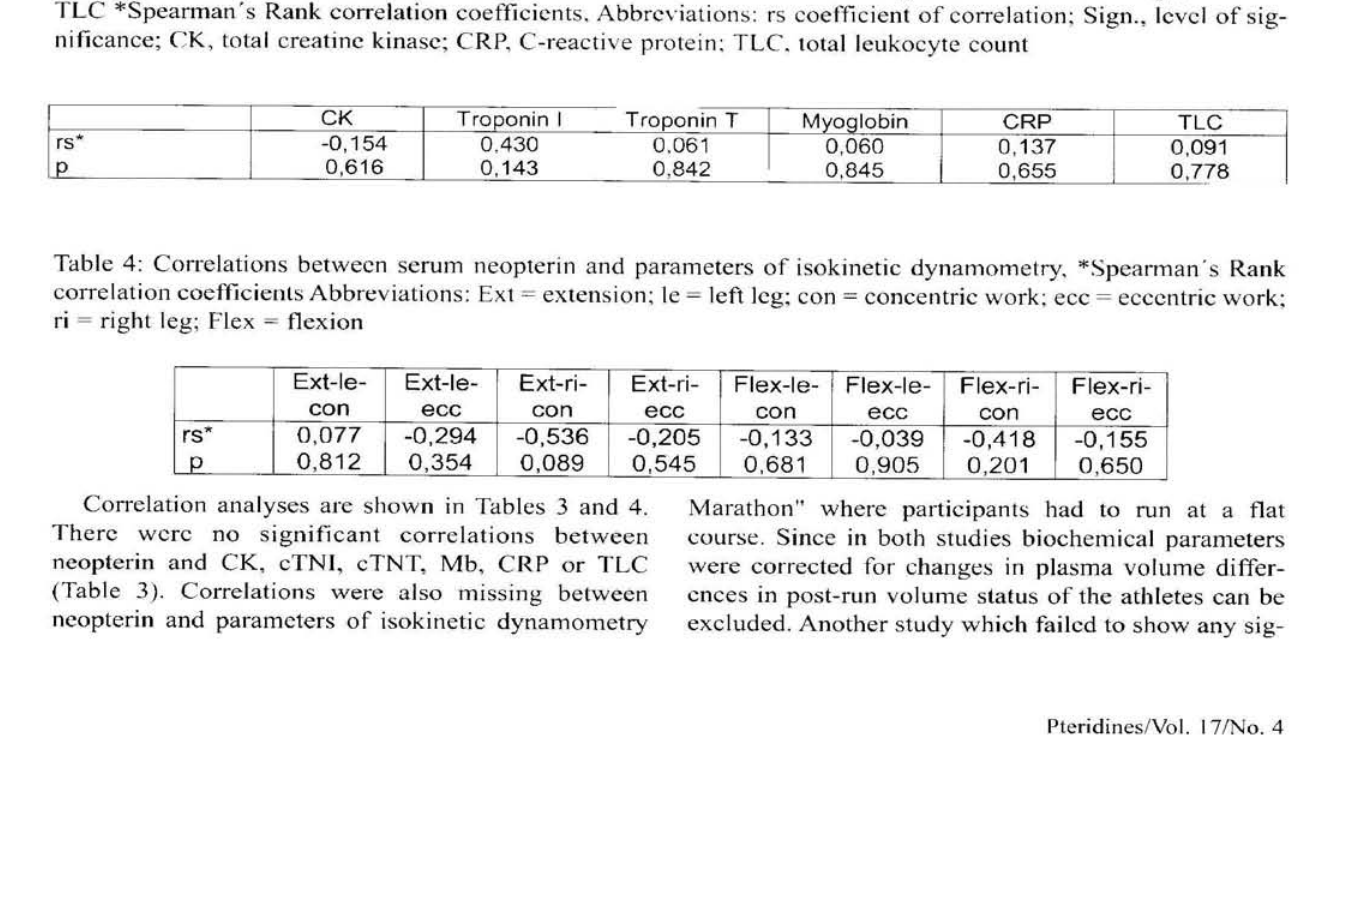
Table 3: Correlations between serum neopterin and markers for skeletal and myocardial muscle damage, CRP and TLC * Spearman's Rank correlation coefficients. Abbreviations: rs coefficient of correlation; Sign., level of sig- nificance; CK, total creatine kinase; CRP, C-reactive protein; FLC. total leukocyte count